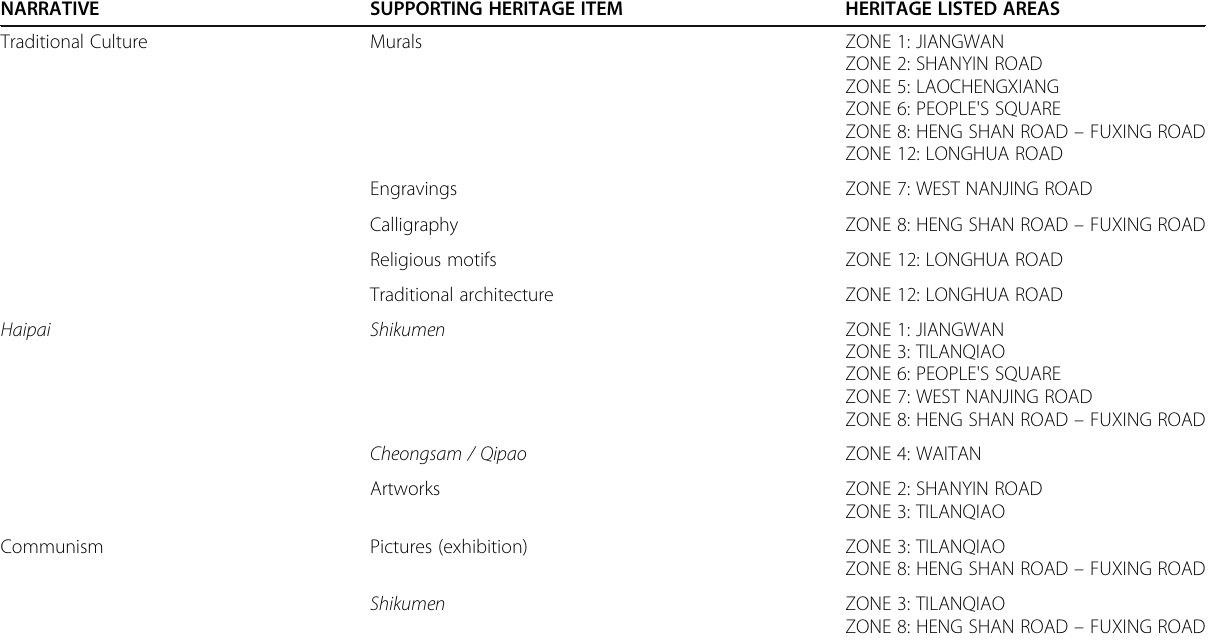
Table 3 Main heritage narratives developed in the Shanghai Metro